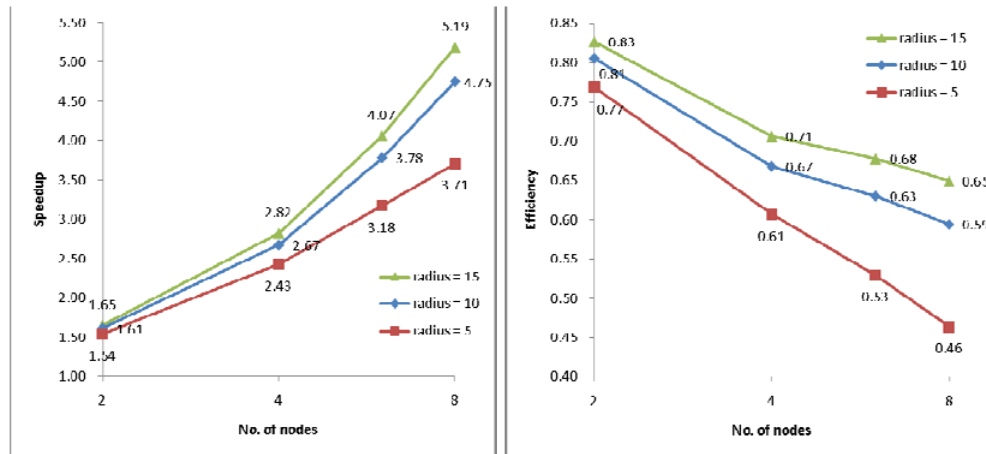
Figure 9a. Speedup for dataset 3. Figure 9b. Efficiency for dataset